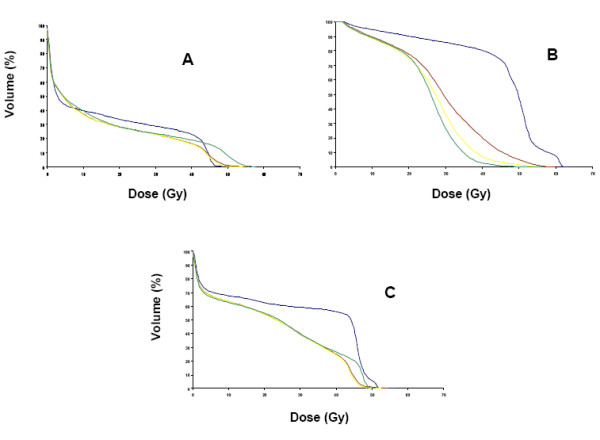
(4A), Mean Dose-Volume Histograms (DVH) for iliac crests of N2-3/T4 group. Arm A, blue; arm B, brown; arm C, yellow; arm D, green; (4B), Mean Dose-Volume Histograms (DVH) for genitalia/perineum of N2-3/T4 group. Arm A, blue; arm B, brown; arm C, yellow; arm D, green; (4C), Mean Dose-Volume Histograms (DVH) for small bowel of N2-3/T4 group. Arm A, blue; arm B, brown; arm C, yellow; arm D, green.